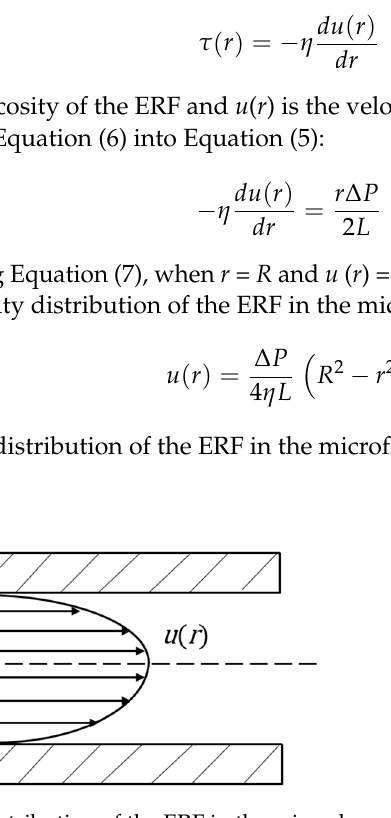
Figure 7. Velocity distribution of the ERF in the microchannel without an electric field. According to Figure 7, the liquid flow in the microchannel can be obtained as: 𝑄 =2 𝜋 (cid:3505) 𝑢(𝑟)𝑟𝑑𝑟 (cid:3019) (cid:2868) = 𝜋𝑅 (cid:2872) 8𝜂𝐿 Δ𝑃 (9) Finally, the relationship between the pressure difference at the outlet and the inlet of the microchannel without an electric field can be obtained as: